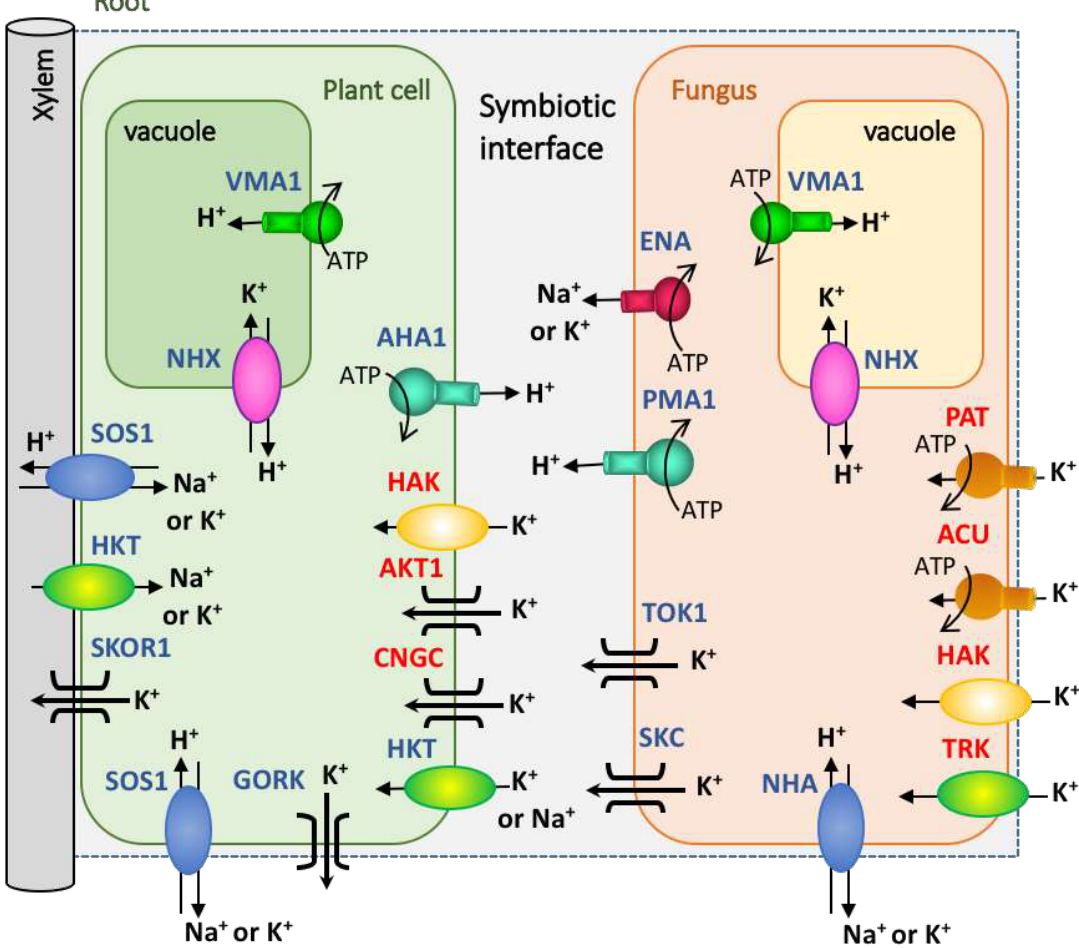
Figure 2. Proposal of the transportome for K + nutrition in plant-fungal symbiosis. The di ff erent families of plant and fungal K + transporters and channels identified so far are depicted. In red letters are marked the putative main players involved in K + uptake. The H + -ATPases are represented as chief responsible for the maintenance of the membrane potential. In the fungal K + acquisition, TRK, HAK, ACU or PAT would contribute taking up K + at di ff erent ranges of substrate